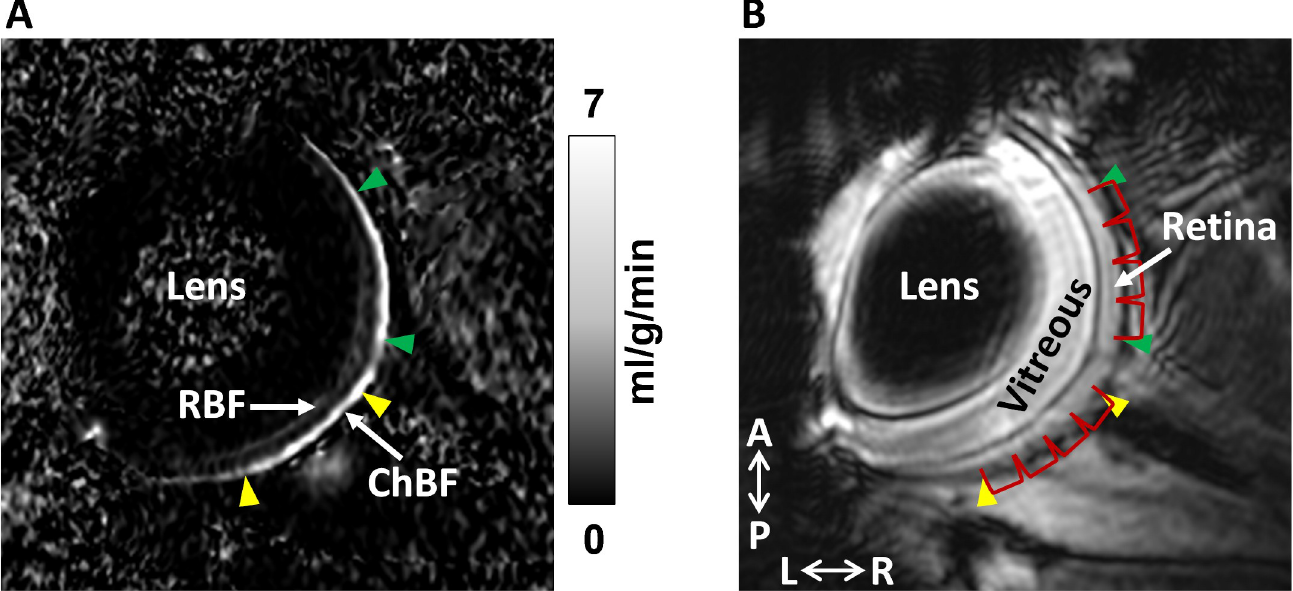
Fig 4. Example MRI blood flow map of a mouse eye (A) and corresponding anatomical EPI image (B) . Retinal blood flow (RBF) and choroidal blood flow (ChBF) are indicated. The regions from which blood flow were measured are indicated as the regions between the two green (nasal) or the two yellow (temporal) arrowheads. The four bins from both regions from which data were averaged over for plotting in Fig 5 are indicated by red brackets. A: anterior, P: posterior, L: left, R: right. The blood flow map is scaled from 0 to 7 ml/g/min.